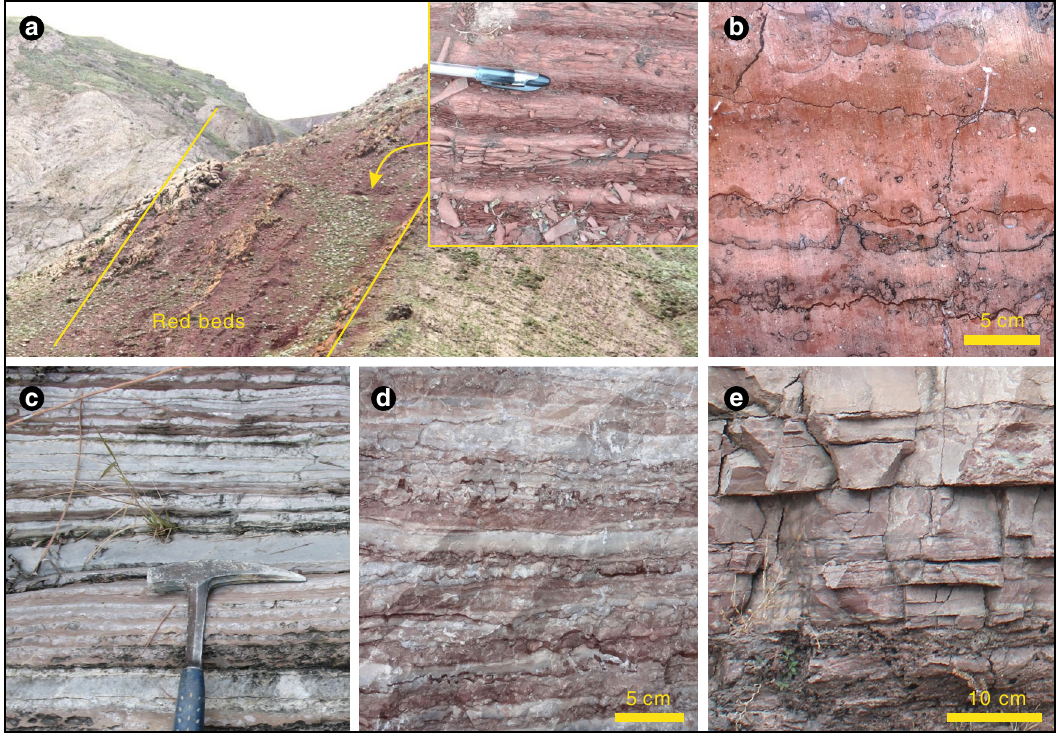
Fig. 1 Representative marine red beds from Ediacaran and Phanerozoic successions. a Late Cretaceous mudstone interbedded with shale (Chuangde Formation, Tibet) containing abundant plankton foraminifers, indicating a pelagic facies. b Early Jurassic limestone (Adnet Formation, Austria) with abundant ammonites, suggesting a deep water environment. c Early Triassic, interbedded grey and red limestones (offshore facies) from the Luolou Formation, South China. d Late Devonian grey and red limestone (offshore facies) from the Wuzhishan Formation, South China. e Middle Ediacaran dolostone interbedded with silty shale from Krol B, Lesser Himalaya,